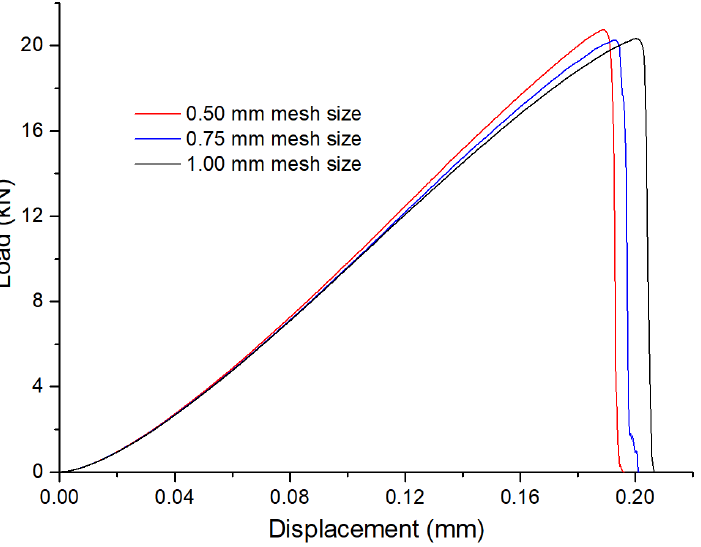
Figure A1. The influence of mesh size on the loading curve for the Type I Brazilian testing.